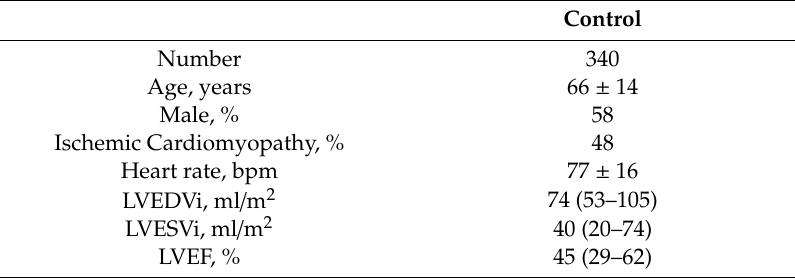
Table 1. Baseline characteristics of the study